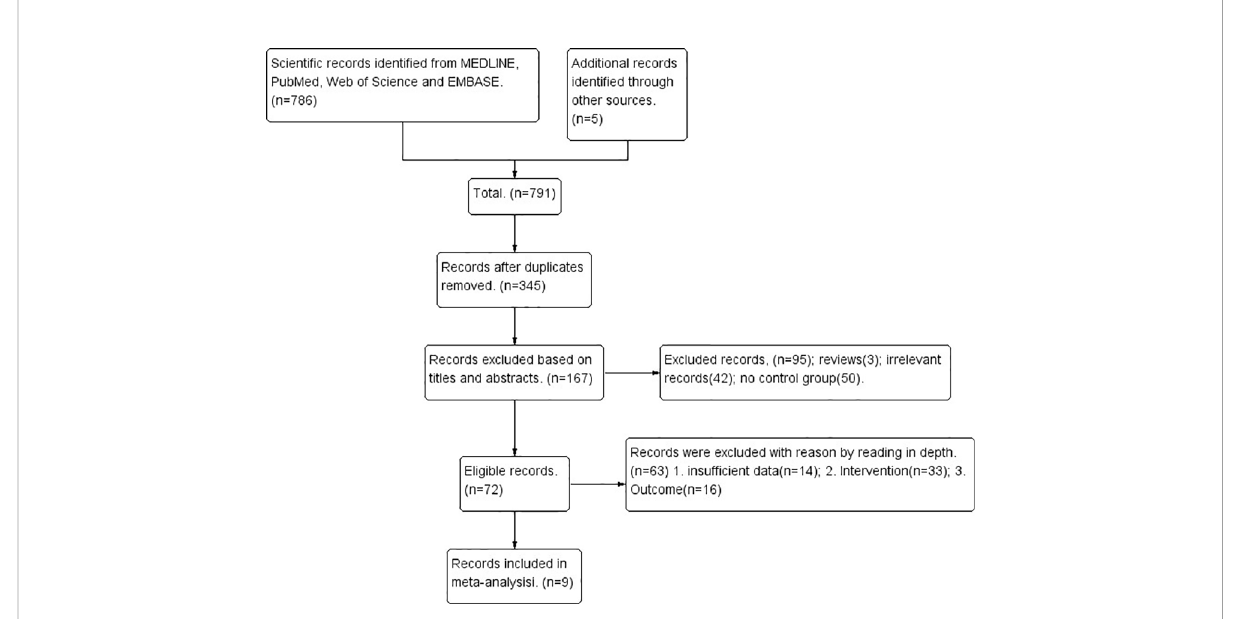
FIGURE 1 PRISMA fl ow diagram showing a selection of articles for meta-analysis.